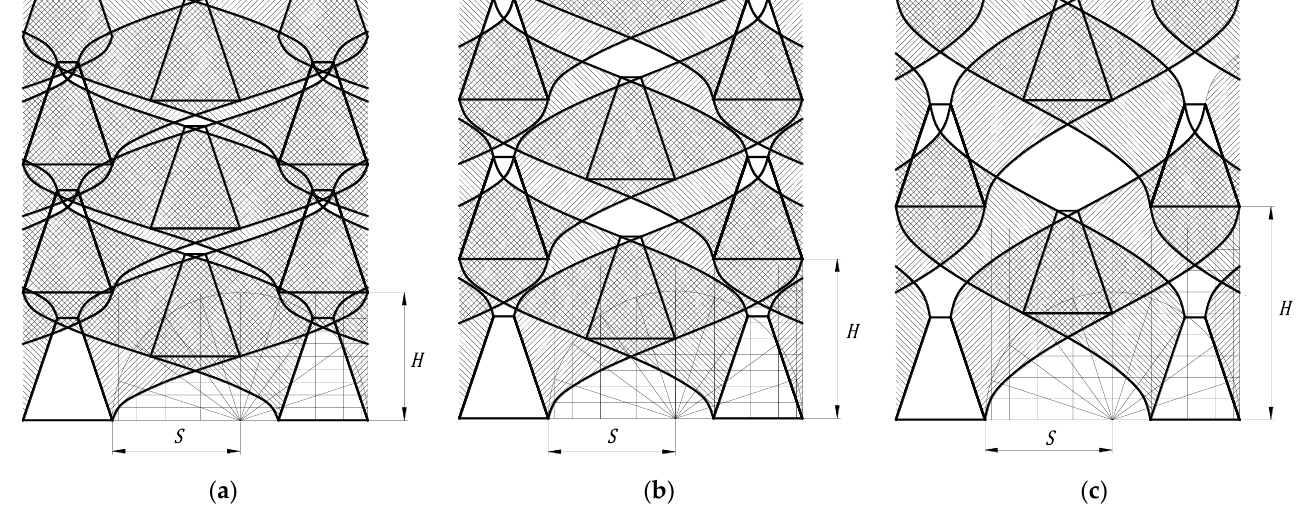
Figure 6. Cutting diagram with different rate ratios: ( a ) λ = 1.0; ( b ) λ = 0.8; ( c ) λ = 0.6.